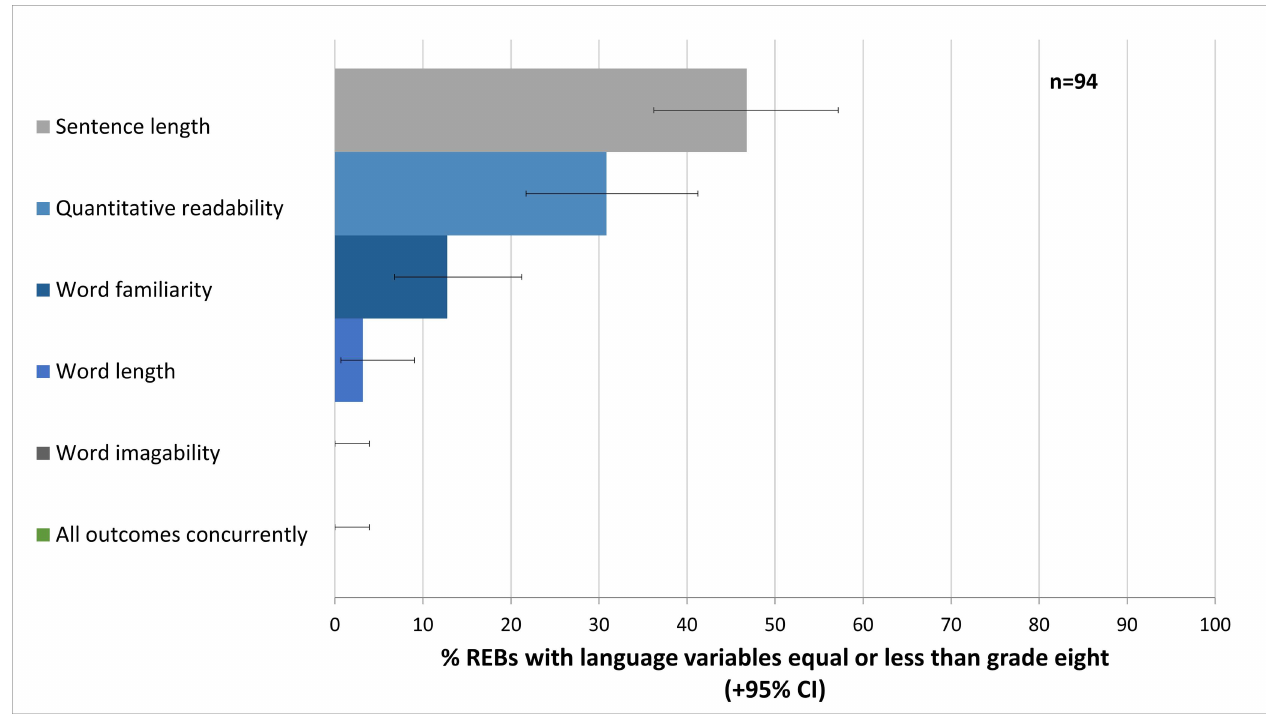
Fig 1. The proportion of researchethics boards providing language variables equal or less than the grade eight